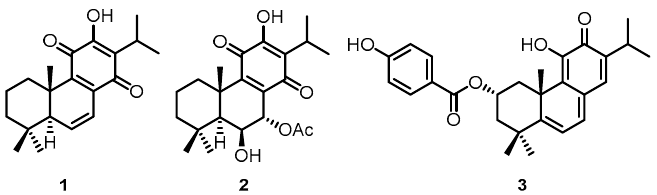
Figure 1. ( 1 ) 6,7-dehydroroyleanone (DeRoy); ( 2 ) 7 α -acetoxy-6 β -hydroxyroyleanone (Roy); and ( 3 ) Parvifloron D (ParvD) isolated from Plectranthus spp.